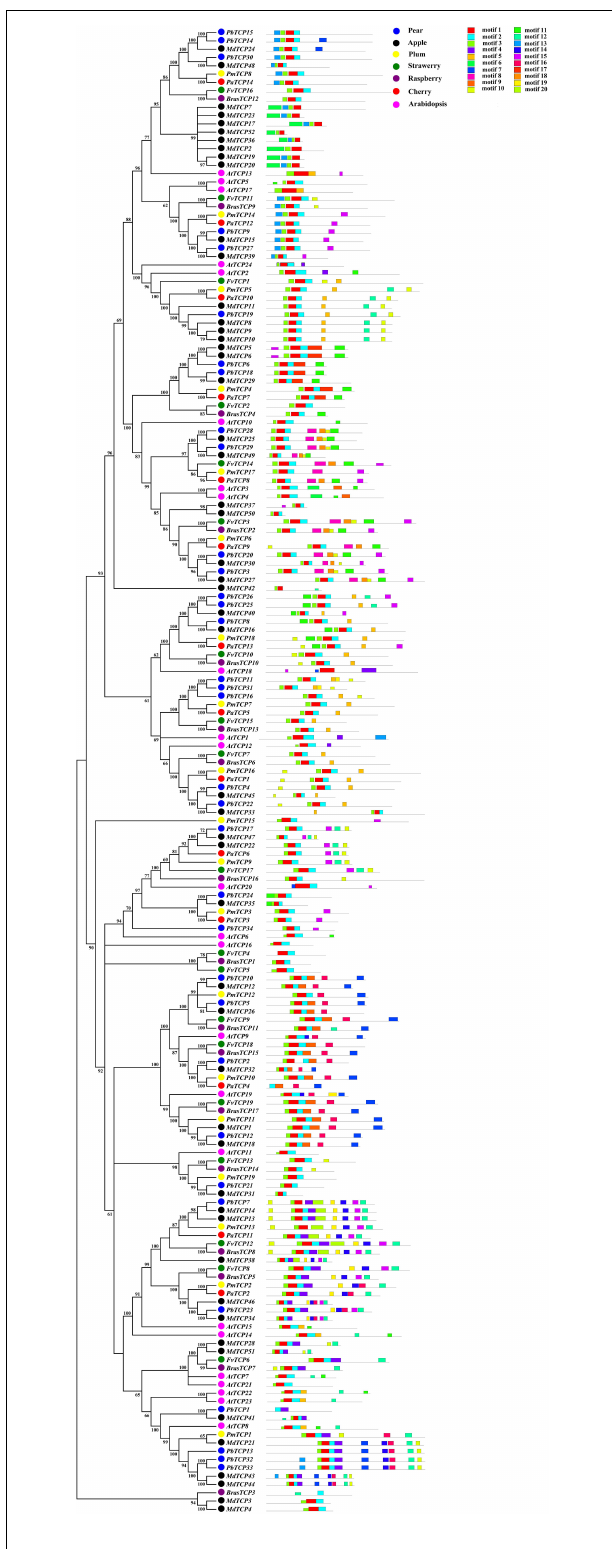
FIGURE 2 | Predicted Pyrus bretschneideri , Fragaria vesca , Prunus mume , Rubus occidentalis , Malus domestica , Prunus avium, and Arabidopsis thaliana TCP protein conserved